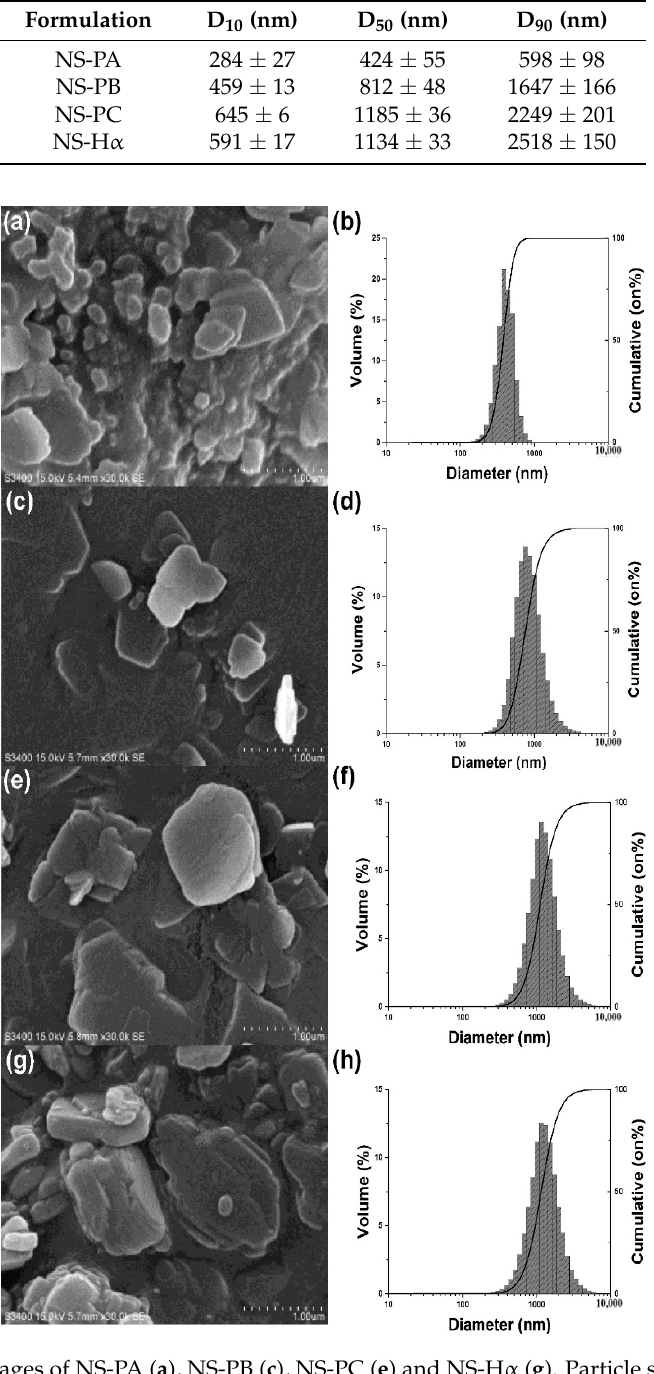
Figure 2. SEM images of NS-PA ( a ), NS-PB ( c ), NS-PC ( e ) and NS-H α ( g ). Particle size of NS-PA ( b ), NS-PB ( d ), NS-PC ( f ) and NS-H α ( h ) measured by laser diffraction instrument. Table 2. Preparation, concentrations, and particle sizes.